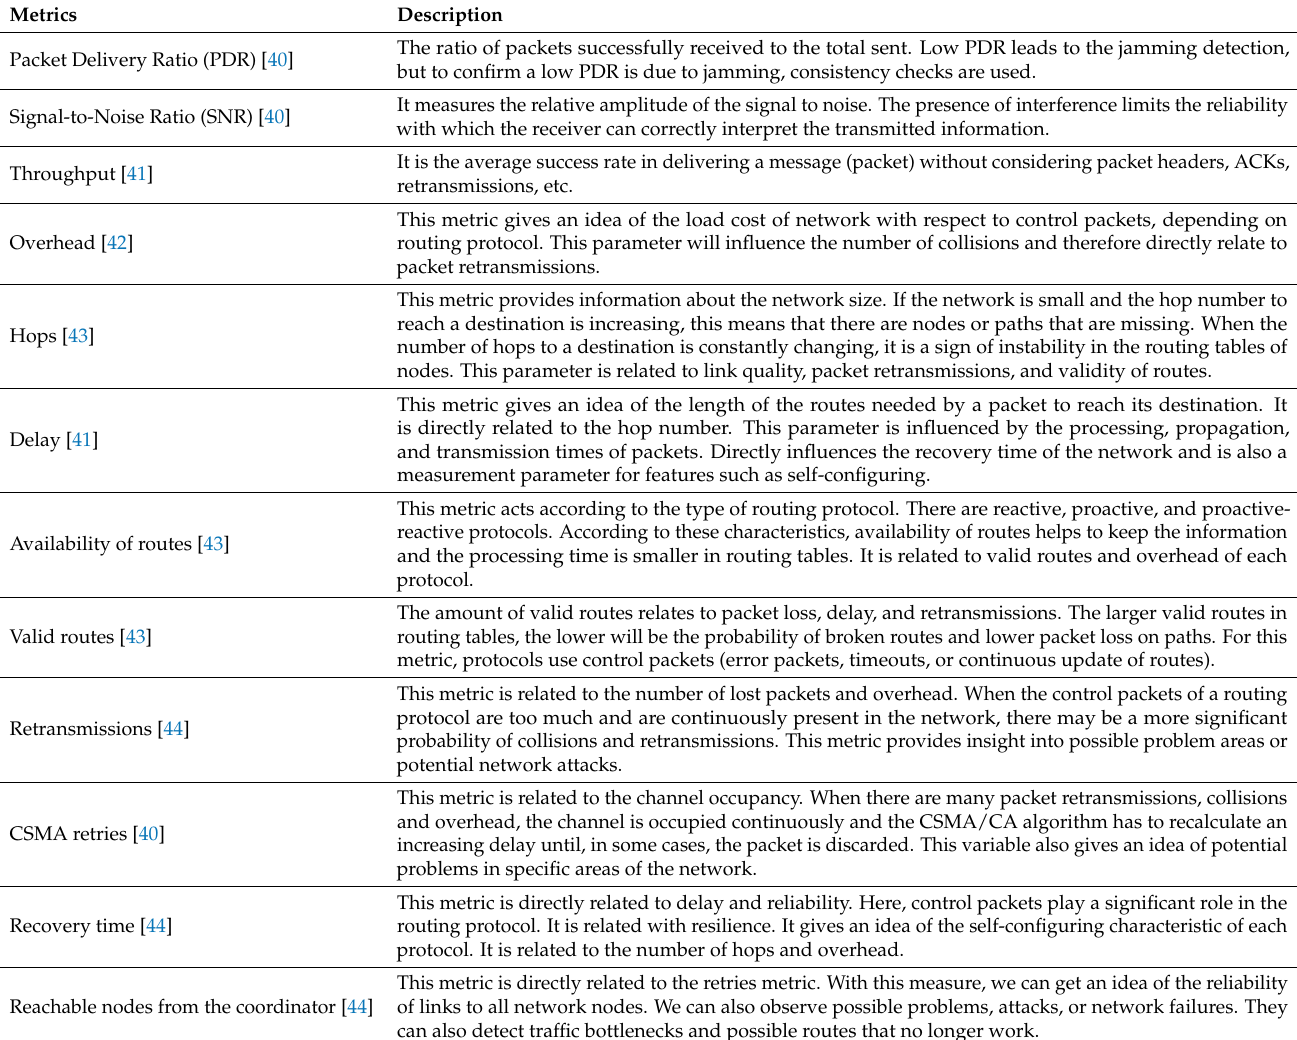
Table 3. Metrics impact on jamming